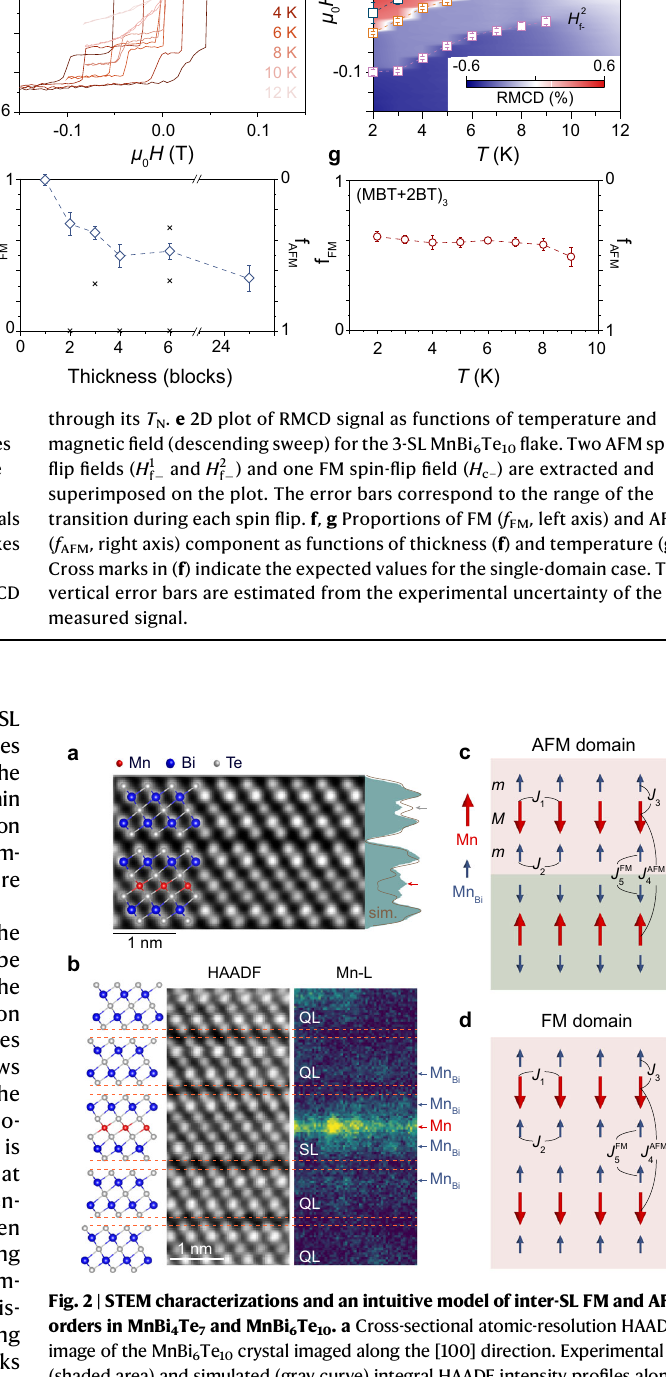
Fig. 2 | STEM characterizations and an intuitive model of inter-SL FM and AFM orders in MnBi 4 Te 7 and MnBi 6 Te 10 . a Cross-sectional atomic-resolution HAADF image of the MnBi 6 Te 10 crystal imaged along the [100] direction. Experimental (shaded area) and simulated (gray curve) integral HAADF intensity pro fi les along the c -axis show clear discrepancy, showing Bi Mn antisite defects in SL (red arrow) and Mn Te in QL (gray arrow). b Atomic structure and HAADF image of the MnBi 6 Te 10 crystal with the corresponding EEELs mapping of the Mn element (L 2,3 edge).ClearMnsignalsarepresentintheBilayersofSLandQL.Theorangedashed lines indicate the van der Waals gaps. c , d Illustrations of the inter-SL FM and AFM regions in MnBi 4 Te 7 and MnBi 6 Te 10 , in which the dominant magnetic exchange interactions are